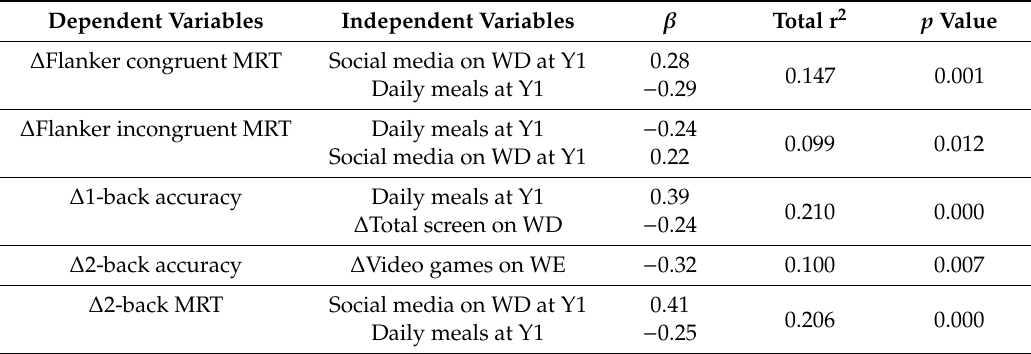
Table 5. Hierarchical regression analysis regarding independent predictors of cognitive control in high school female students.